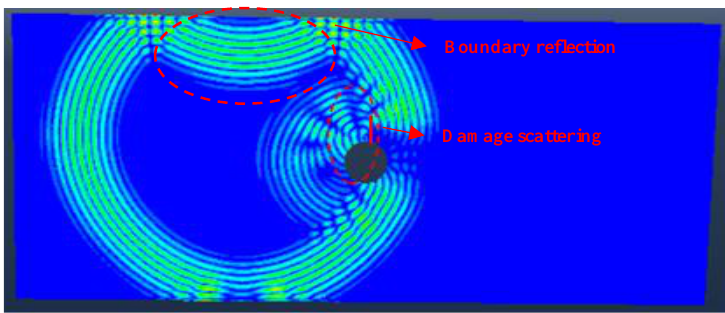
Figure 5. Total displacement nephogram of simulated wave propagation at 85 μ s.